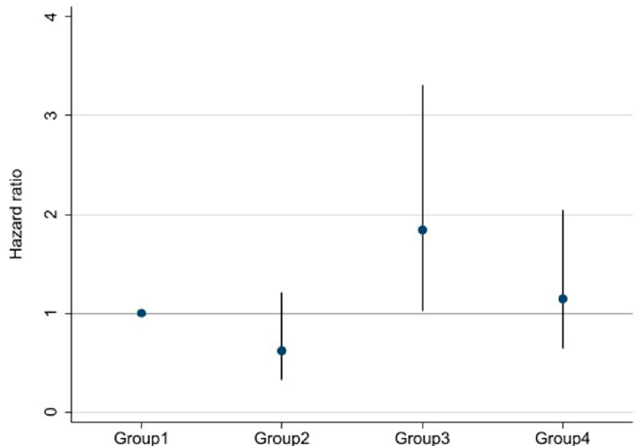
Figure 3. Kaplan–Meier curve for ≥ 30% decline in eGFR, end-stage renal disease (ESRD), or death. Kaplan–Meier survival curve of outcomes for four groups. Patients were classified into 4 groups according to DSI ( ≤ 6 g/day or >6 g/day) and ECW/TBW ( ≤ median or >median). Cumulative incidences (95% confidence interval) of outcomes defined as a ≥ 30% decline in eGFR from baseline on admission, occurrence of ESRD, or death are shown.